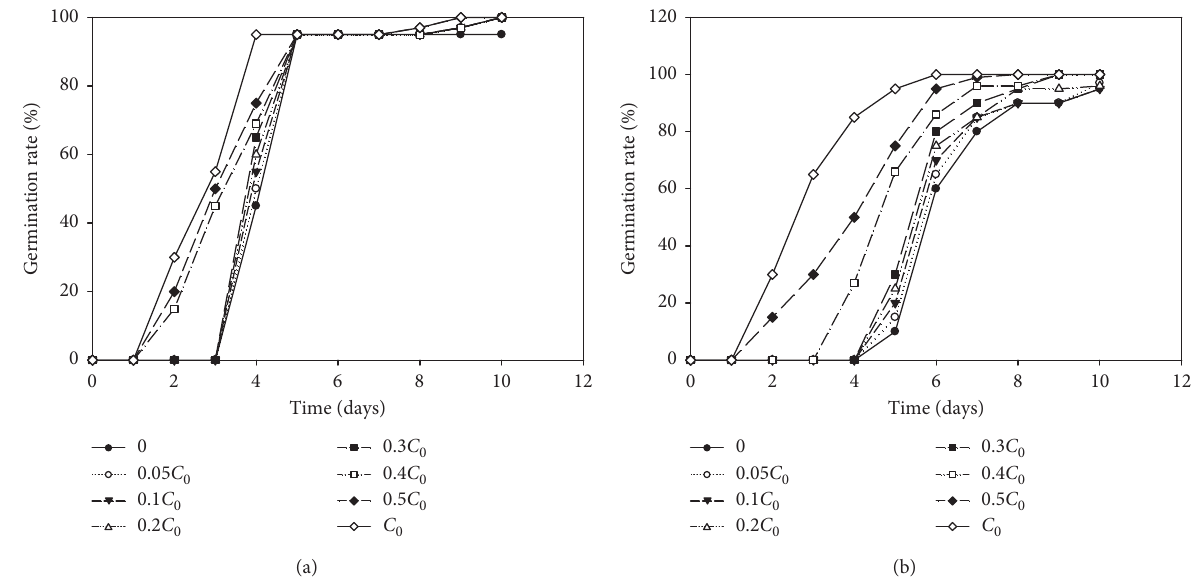
Figure 3: Seed germination percentage in control and algal residual-treated plants of tomato (a) and rice (b) ( n � 3, p < 0 . 05). Total phytohormone concentration, C 0 � 1062.7 (auxins, μ g/L)+2000.1 (gibberellins, μ g/L) � 3062.8 μ